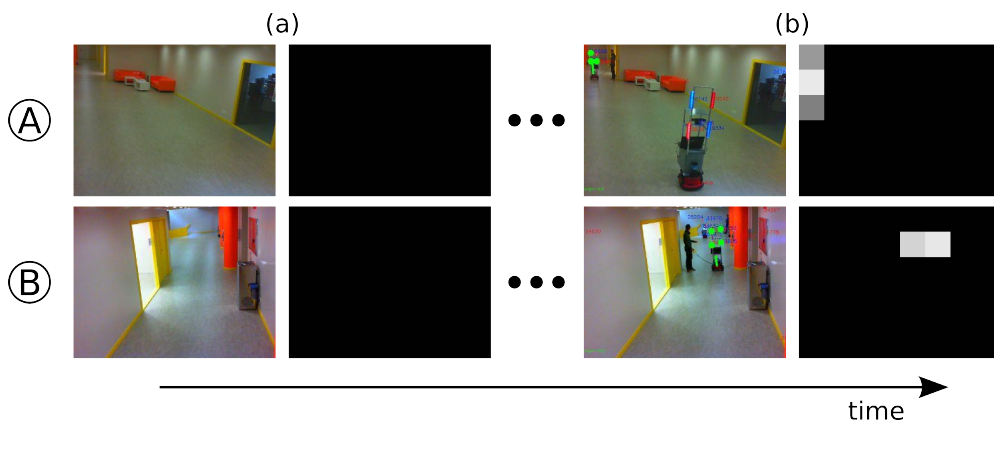
Figure 4. Evolution of the Neighbourhood Probability of two cameras A and B through